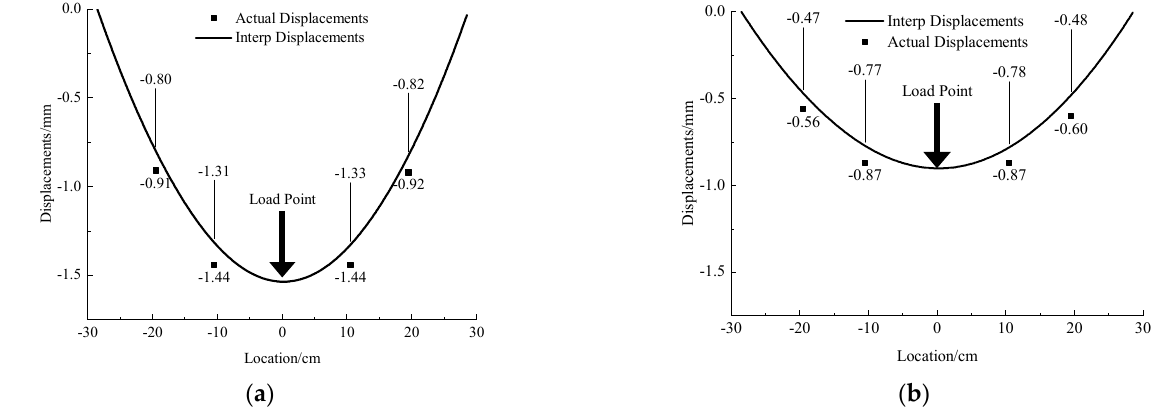
Figure 6. Deformation curve and measured displacement of single acrylic tunnel with 2 mm and 3 mm thickness under concentrated load. ( a ) 2 mm. ( b ) 3 mm.